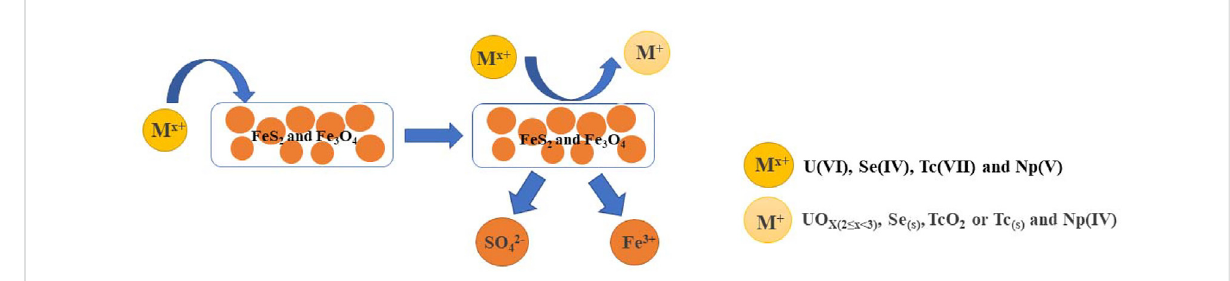
FIGURE 15 Scheme of mechanism for reduction